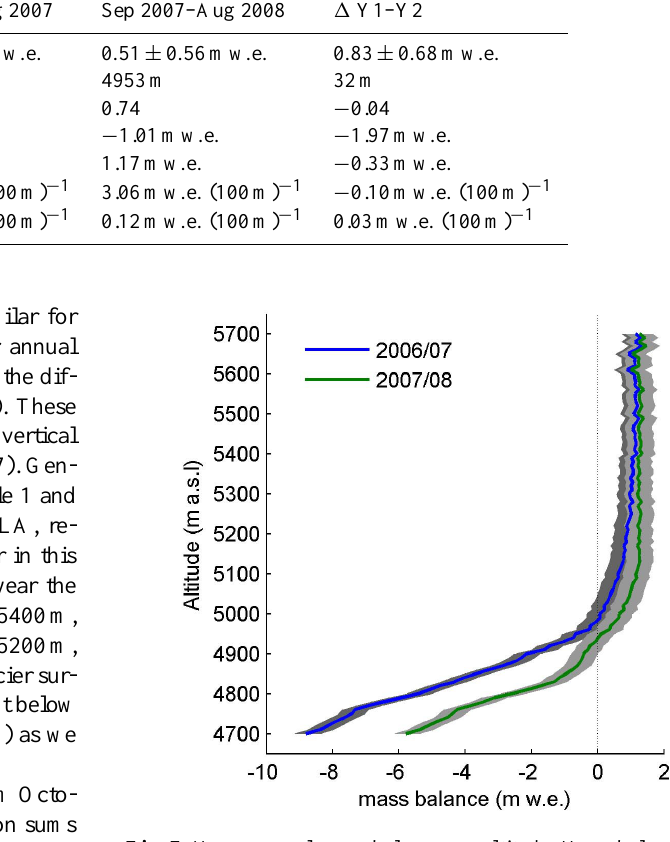
Fig. 7. Mean annual mass balance vs. altitude. Mass balance val- ues are calculated as annual means for 10m elevation increments. The grey areas indicate the estimated error ranges for each year (Sect.